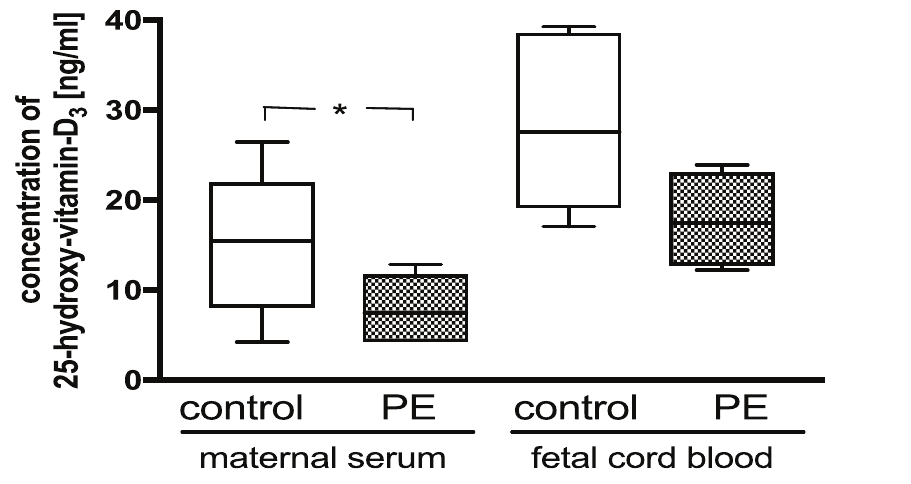
Fig 1. 25(OH) vitamin D concentrations (ng/ml) in the individual maternal serum samples prior delivery and umbilical cord blood after delivery. * P < 0.05 vs. control. The ends of the whiskersrepresent the maximum and minimummeasuredvalues. Distribution was examinedusing Kolmogorov- Smirnov test. Continuous data were comparedwith unpairedt-test.